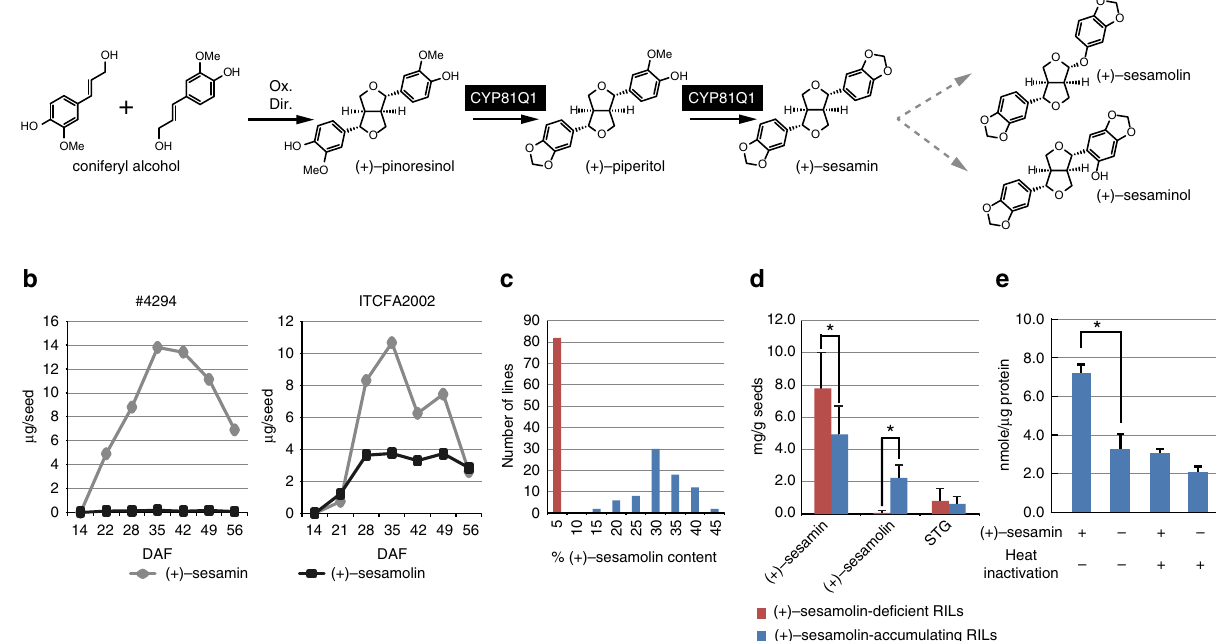
Fig. 1 Biosynthesis of (+)-sesamolin. a Putative biosynthetic pathway of (+)-sesamolin. Ox: oxidant, Dir: dirigent protein, dashed gray arrows; reactions catalyzed in this study. b The amounts of (+)-sesamin and (+)-sesamolin in the sesame lines ITCFA2002 and #4294 during seed development. DAF; days after fl owering. c The number of individual RILs (F6) generated by crossing #4294 and ITCFA2002 was plotted against (+)-sesamolin (%) relative to the total lignan content. red; RILs accumulating less than 5% (+)-sesamolin, blue; RILs accumulating 15 – 45% (+)-sesamolin. d Amounts (mg/g tissue) of (+)-sesamin, (+)-sesamolin and (+)-sesaminol triglucoside (STG) in mature seeds from (+)-sesamolin-de fi cient (red) and (+)-sesamolin-accumulating (blue) RILs. Values are mean ± SD. * P < 0.05, Mann – Whitney U -test, two-tailed. e (+)-sesamolin biosynthetic activity of the microsome fraction from sesame seeds. The enzyme assays were conducted with or without (+)-sesamin. Heat inactivation: incubation of the microsome fraction at 96 °C for 5 min prior to the assay. Values are mean ± SE ( n = 3). * P < 0.01, Student ’ s t